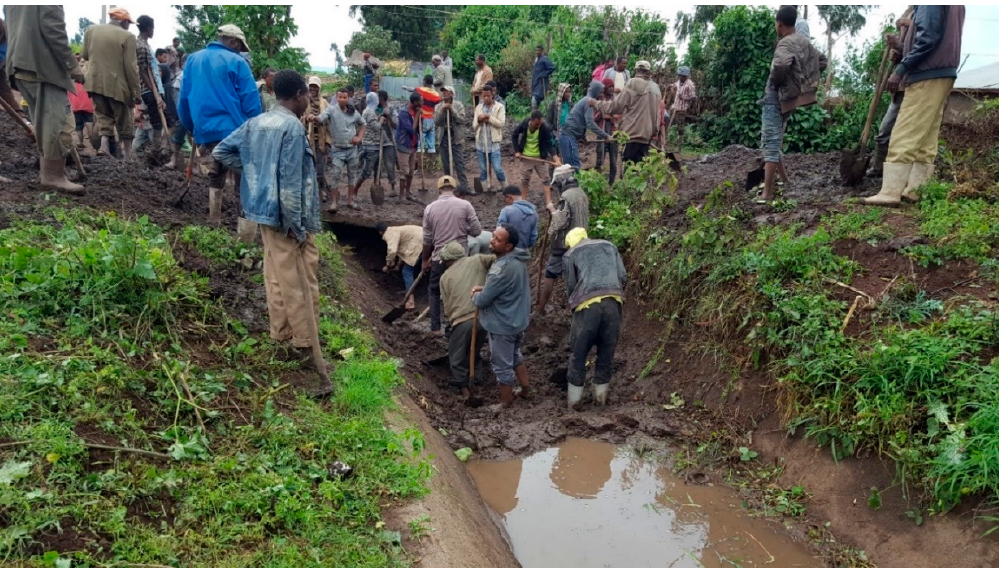
Figure A1. Farmers desilting the sediment from the main canal during the annual desilting campaign at the Ketar irrigation scheme.